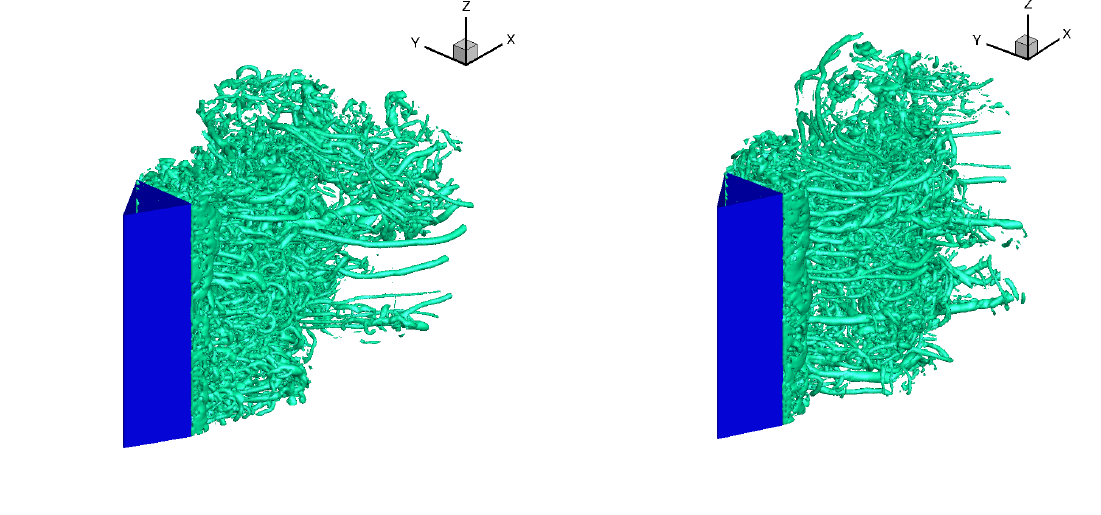
Figure 2. Isosurfaces of the second invariant of the velocity gradient tensor